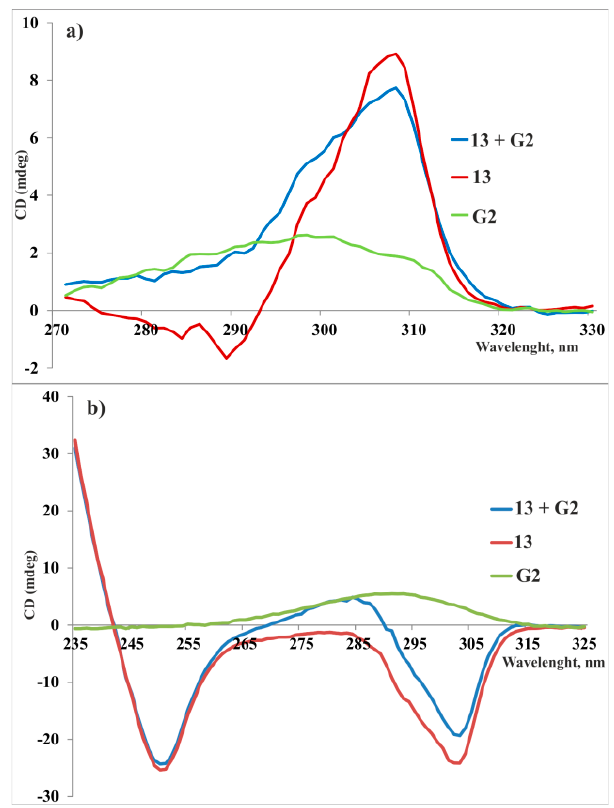
Figure 9. ( a ) CD spectra of compound 13 (red), G2 (green) and their mixture (blue) in DMSO at 1 × 10 − 4 M; ( b ) CD spectra of compound 13 (red), G2 (green) and their mixture (blue) in water at 1 × 10 − 4 M.